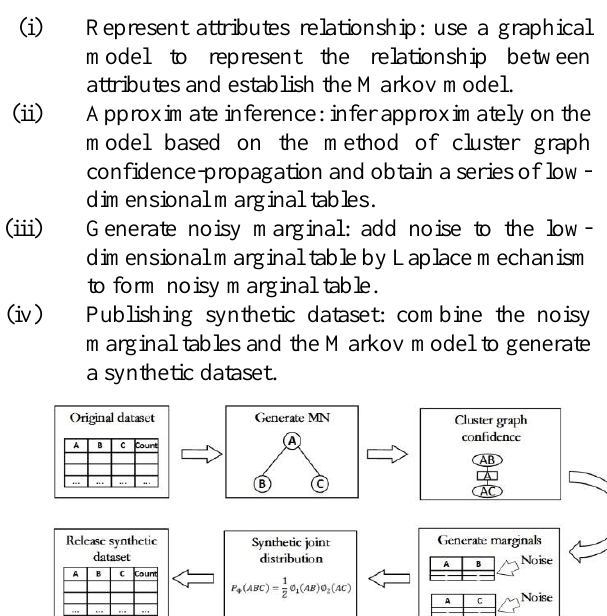
Fig.2. Attributes cluster clique